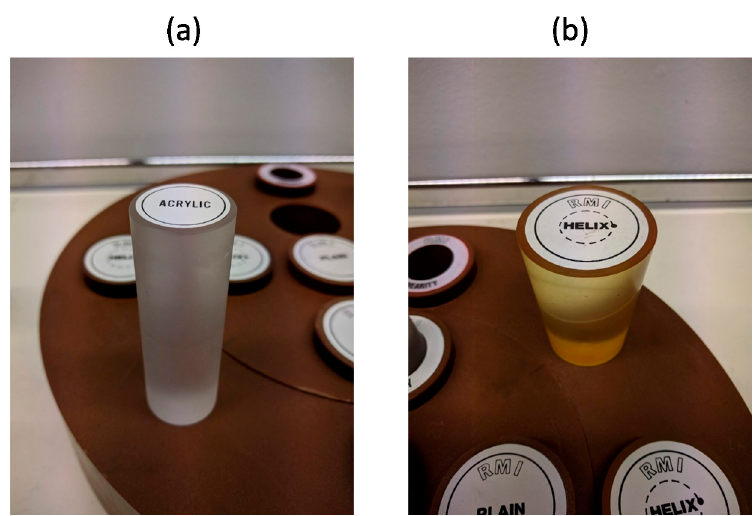
Figure 6. The two Computed Tomography (CT) imaging phantoms, one made of acrylic material ( a ), the other of Lucite and with helix shape ( b ), used to evaluate the segmentation accuracy of the EVAR-eaSE software.